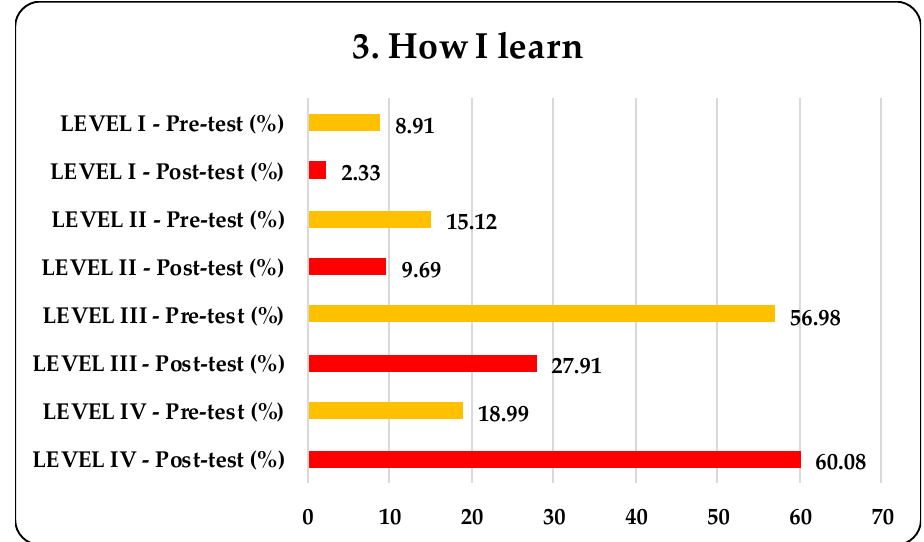
Figure 8. Levels of achievement of the third dimension: How I learn (%).